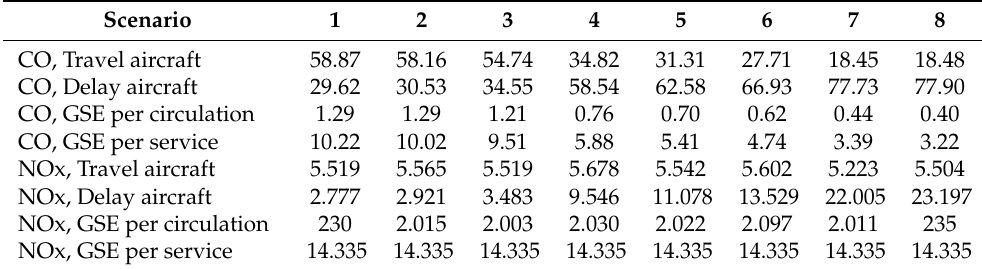
Table 5. Emissions per group and process, in